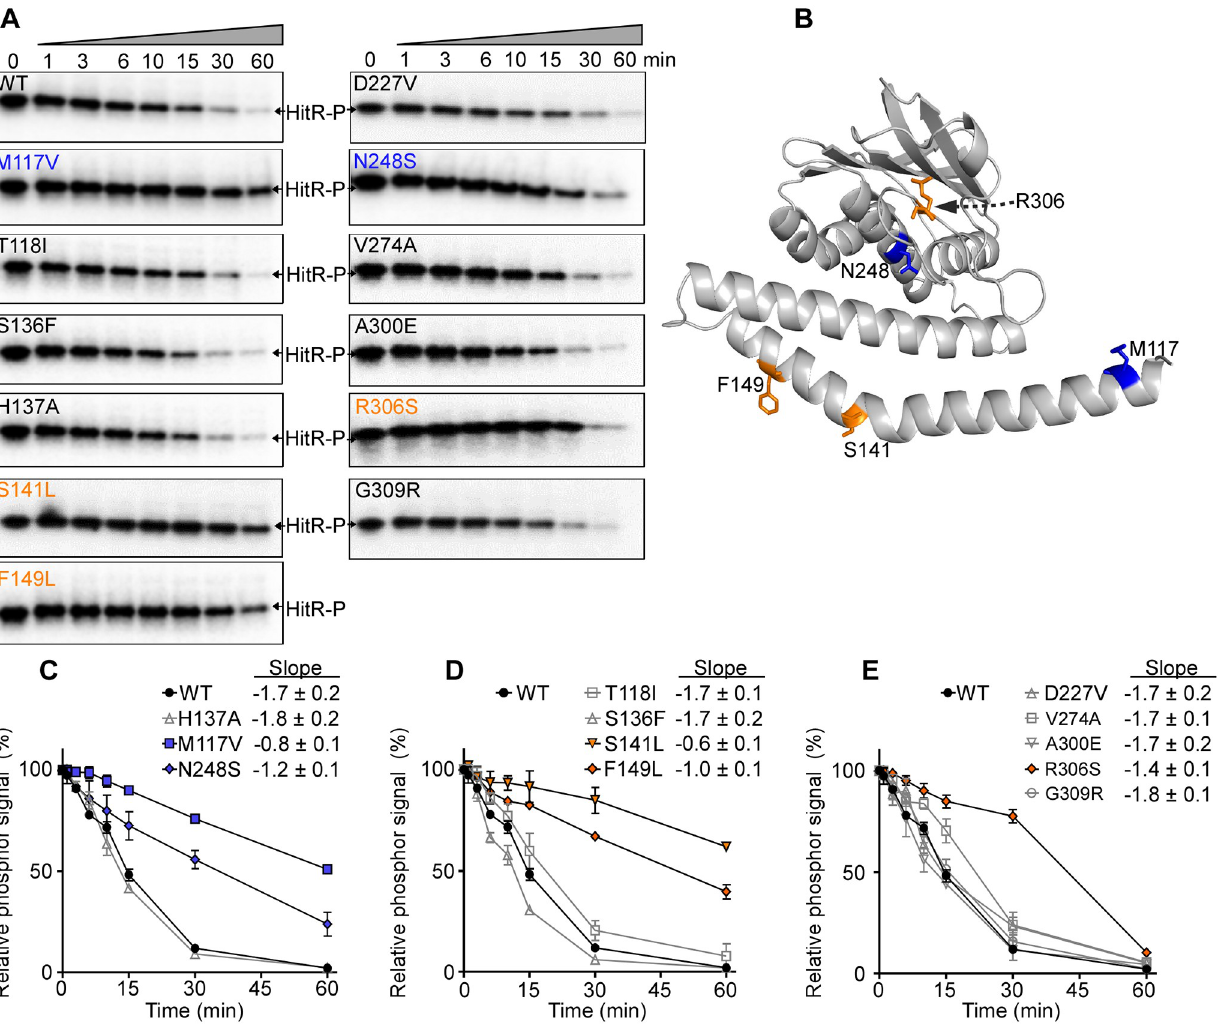
Fig 6. Critical residues required for the phosphatase activity of HitS. To evaluate the effects of HitS mutation on its phosphatase activity, dephosphorylation efficiency of HitS WT and mutants was tested. (A) Representative phospho-images showing the dephosphorylation kinetics of HitS WT or mutants using phosphorylated HitR WT, which was monitored for 60 min. (B) Mutants with altered phosphatase activity were mapped onto the HitS model. (C-E) The intensity of phospho-signal was quantified and relative phospho-signal remaining at different time-points was calculated. Data shown are three independent replicates (mean ± SEM). Mutants were organized into three graphs for optimal visualization. Data of the first four timepoints (i.e., 0, 1, 3, 6 min) for each protein were used for slope determination by linear regression